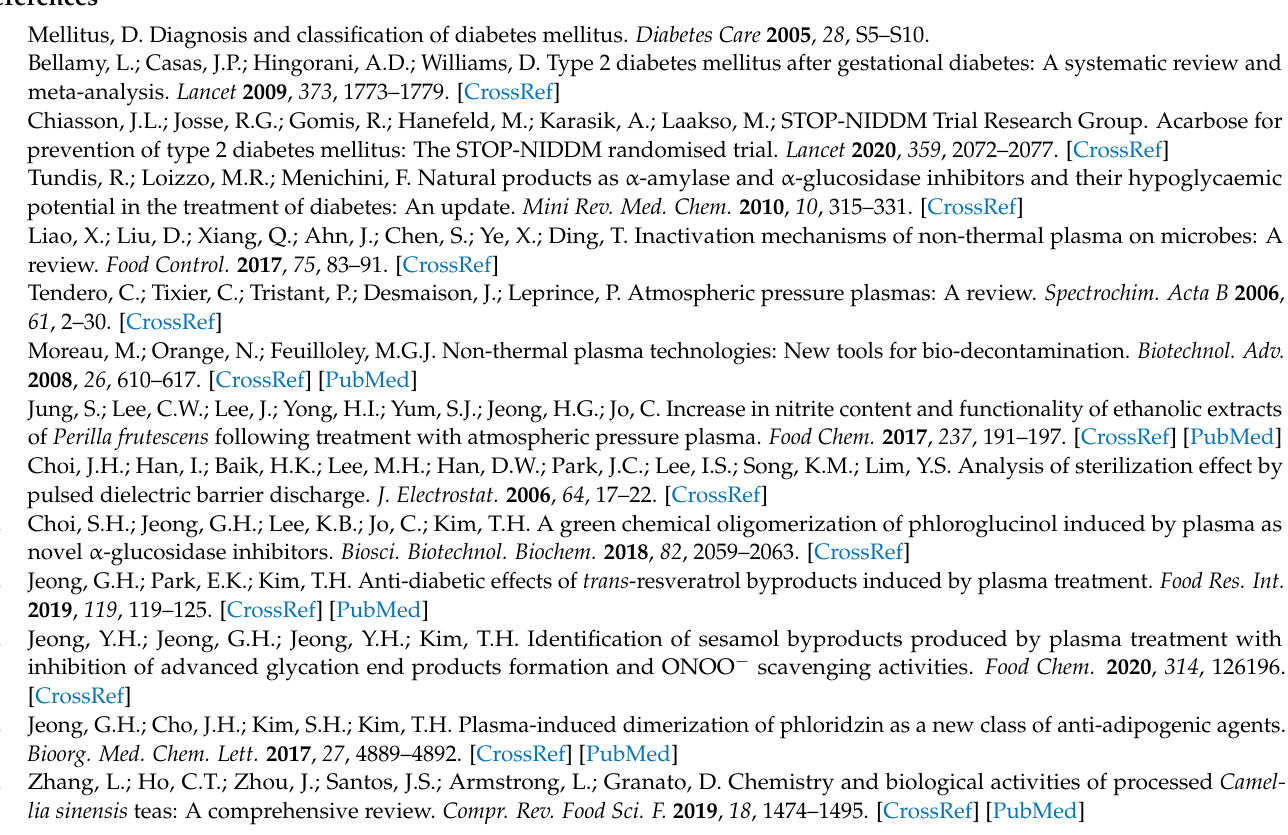
solution, Figure S2: HPLC chromatograms of isolated compounds 1 – 3 , Figure S3: 1H NMR spectrum of compound 1 in CD3OD, Figure S4: 13C NMR spectrum of compound 1 in CD3OD, Figure S5: HSQC spectrum of compound 1 in CD3OD, Figure S6: HMBC spectrum of compound 1 in CD3OD, Figure S7: FABMS spectrum of compound 1 , Figure S8: 1H NMR spectrum of compound 2 in CD3OD, Figure S9: 13C NMR spectrum of compound 2 in CD3OD, Figure S10: FABMS spectrum of compound 2 , Figure S11: 1H NMR spectrum of compound 3 in CD3OD, Figure S12: Calibration curve of EGCG and oxidation products 1 – 3 , Figure S13: Chemical structures of isolated compounds 1 – 3